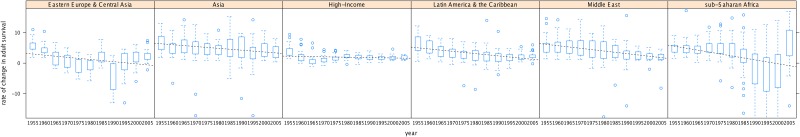
Regional changes in adult survival (deaths per 1000 per year), 1950–2010.Note: mean regional trends in changes in adult survival are indicated by the black dashed lines.